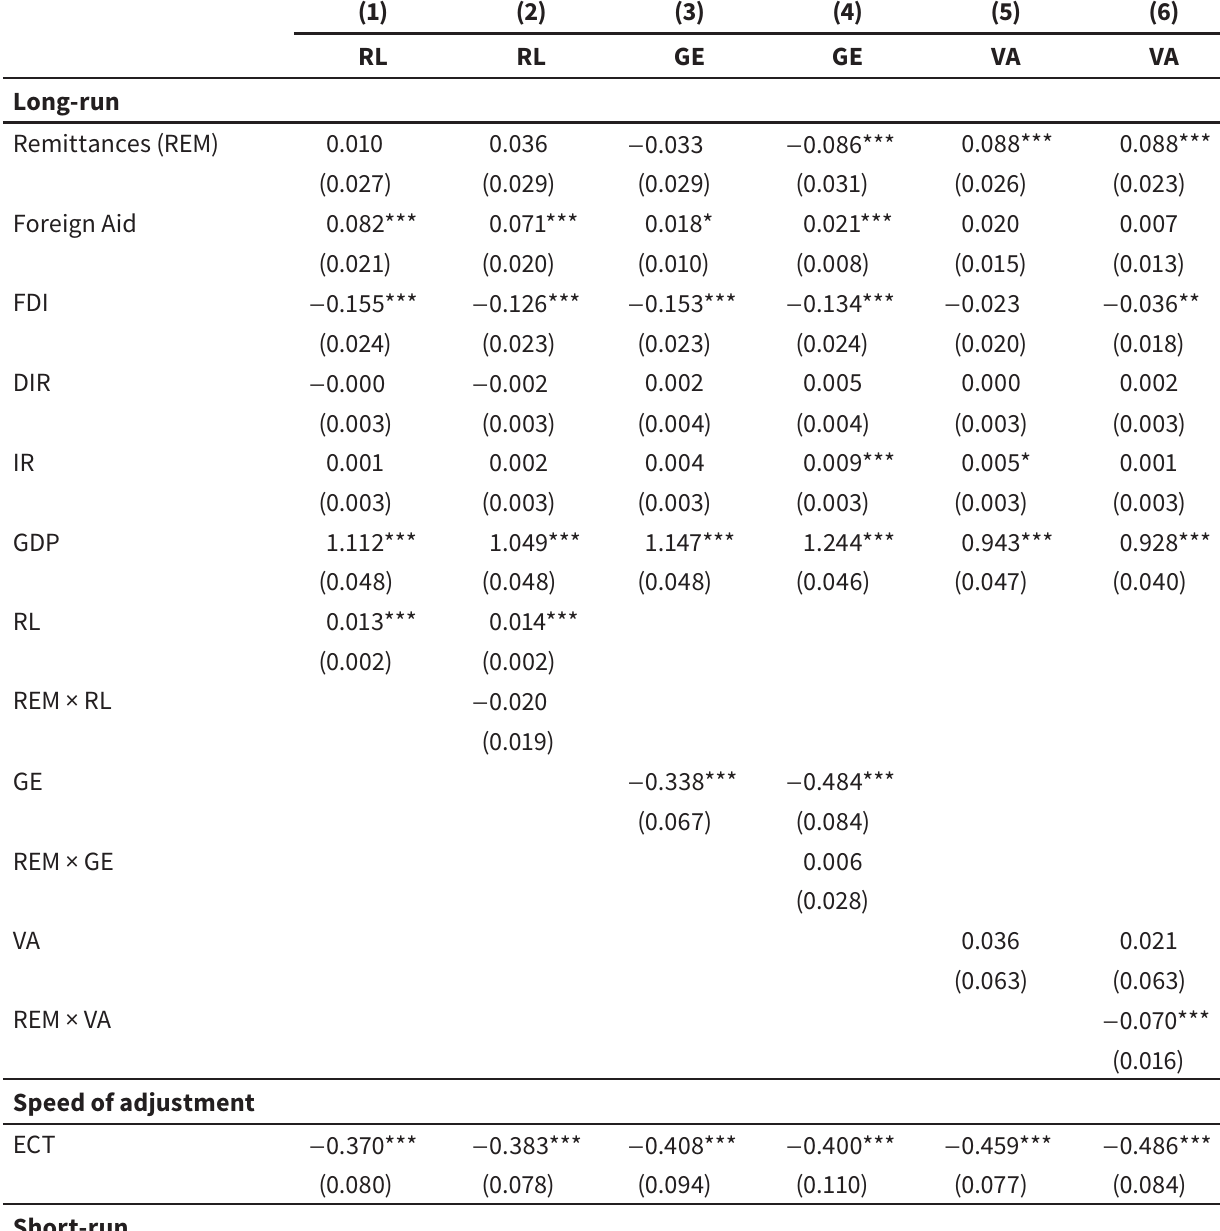
Individual governance quality indicators and